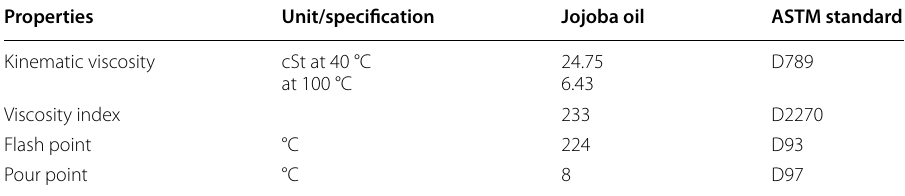
Table 3 Thermo-physical properties of jojoba oil